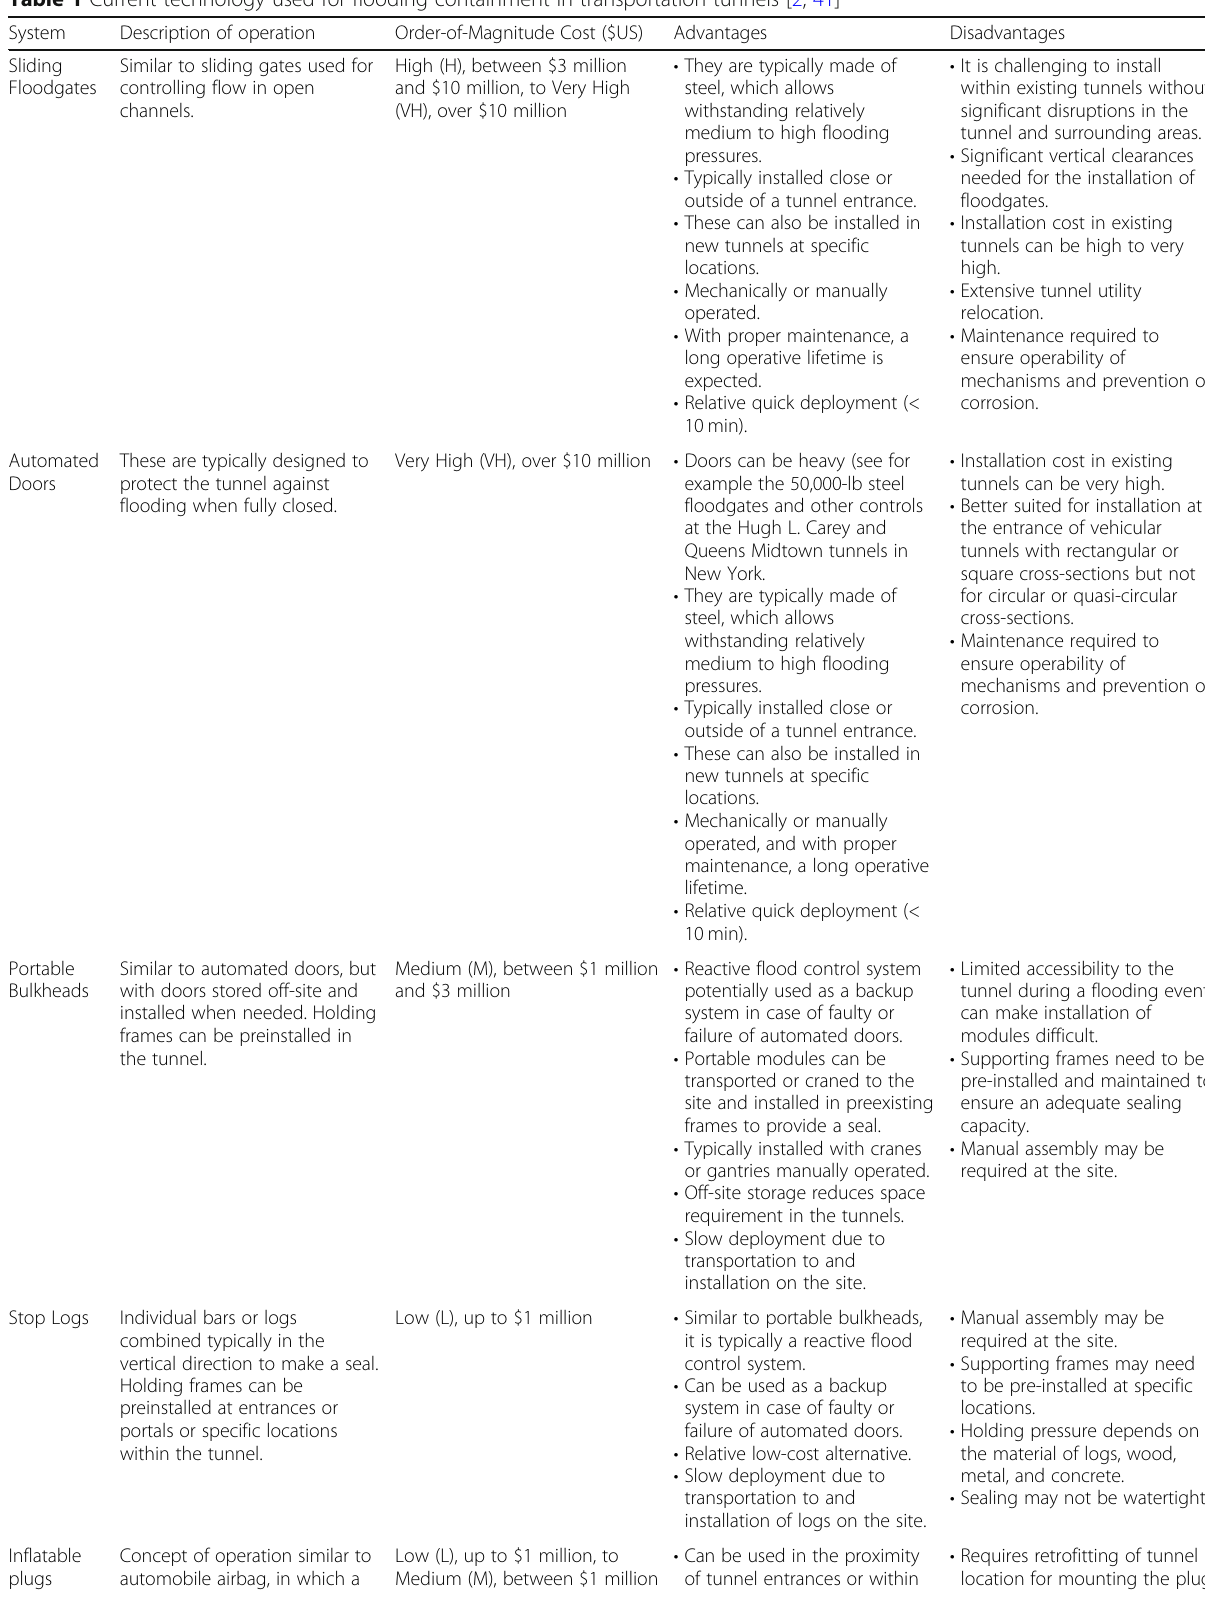
Table 1 Current technology used for flooding containment in transportation tunnels [2, 41] System Description of operation Order-of-Magnitude Cost ($US) Advantages